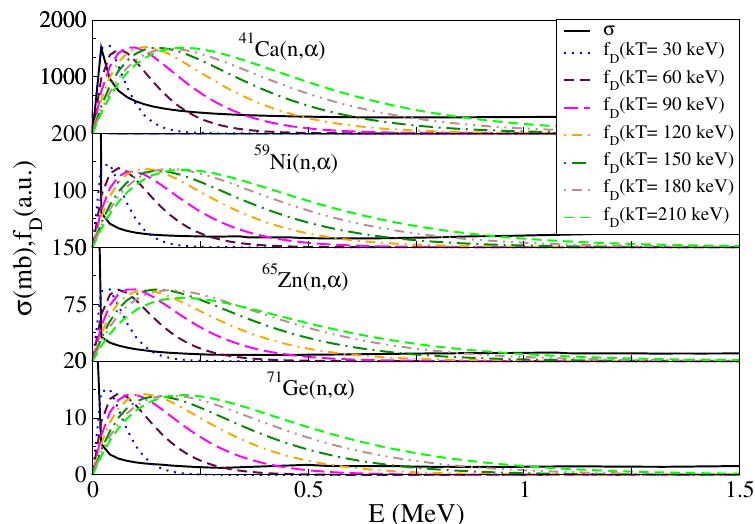
Figure 6. The ( n , α ) reaction cross sections as a function of neutron energy σ ( E ) , and Maxwell- Boltzmann distribution f D ( E ) (in arbitrary units) for the range of temperatures kT = 30–210 keV, shown for 41 Ca, 59 Ni, 65 Zn, and 71